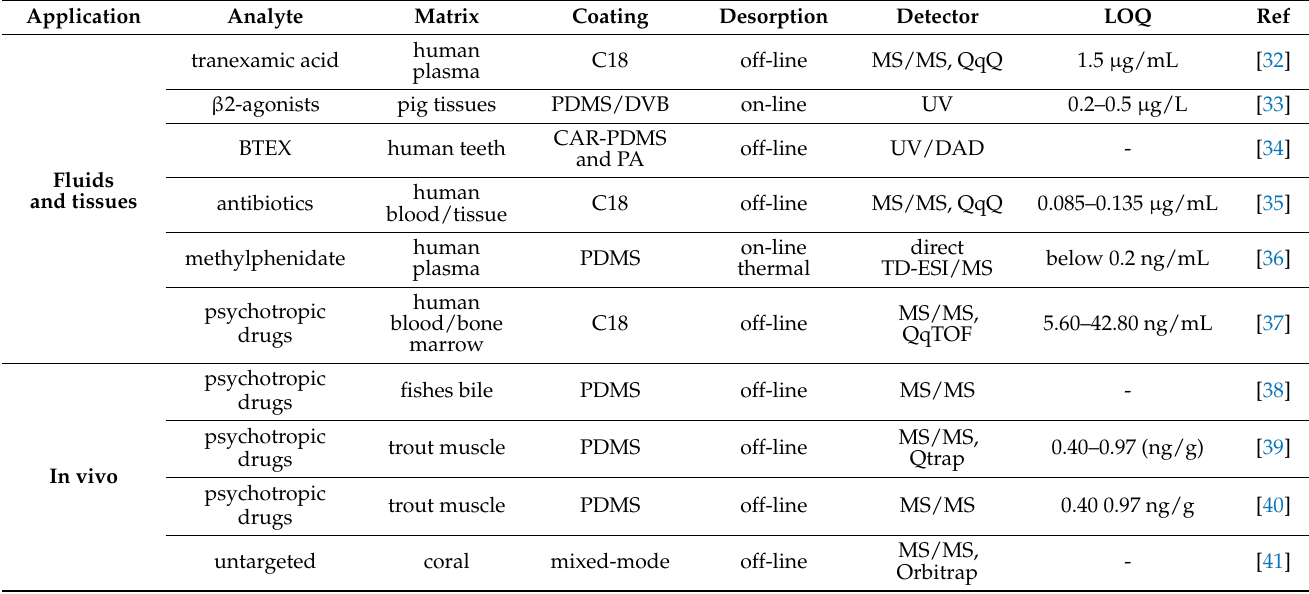
Table 1. Biological applications of